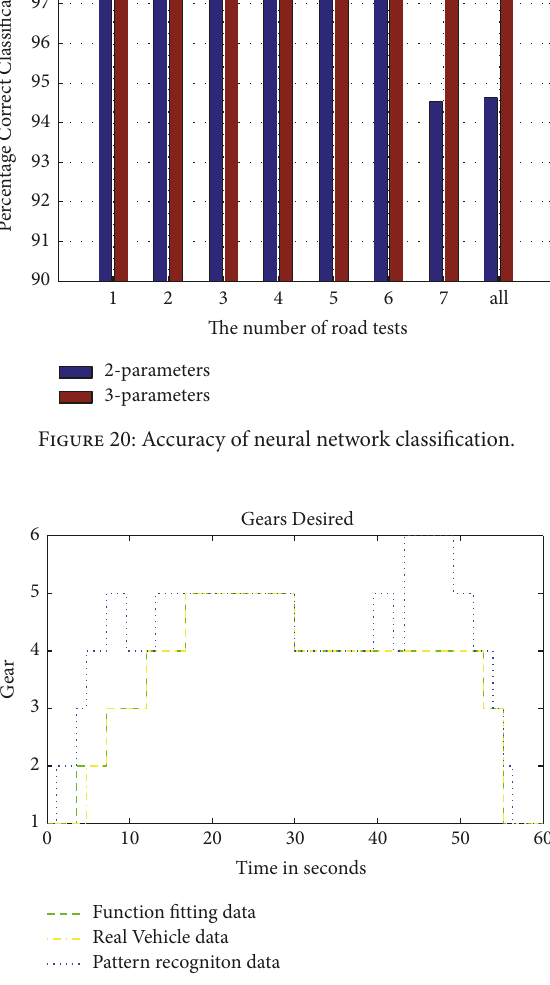
Figure 21: Gear timing of road test 1.